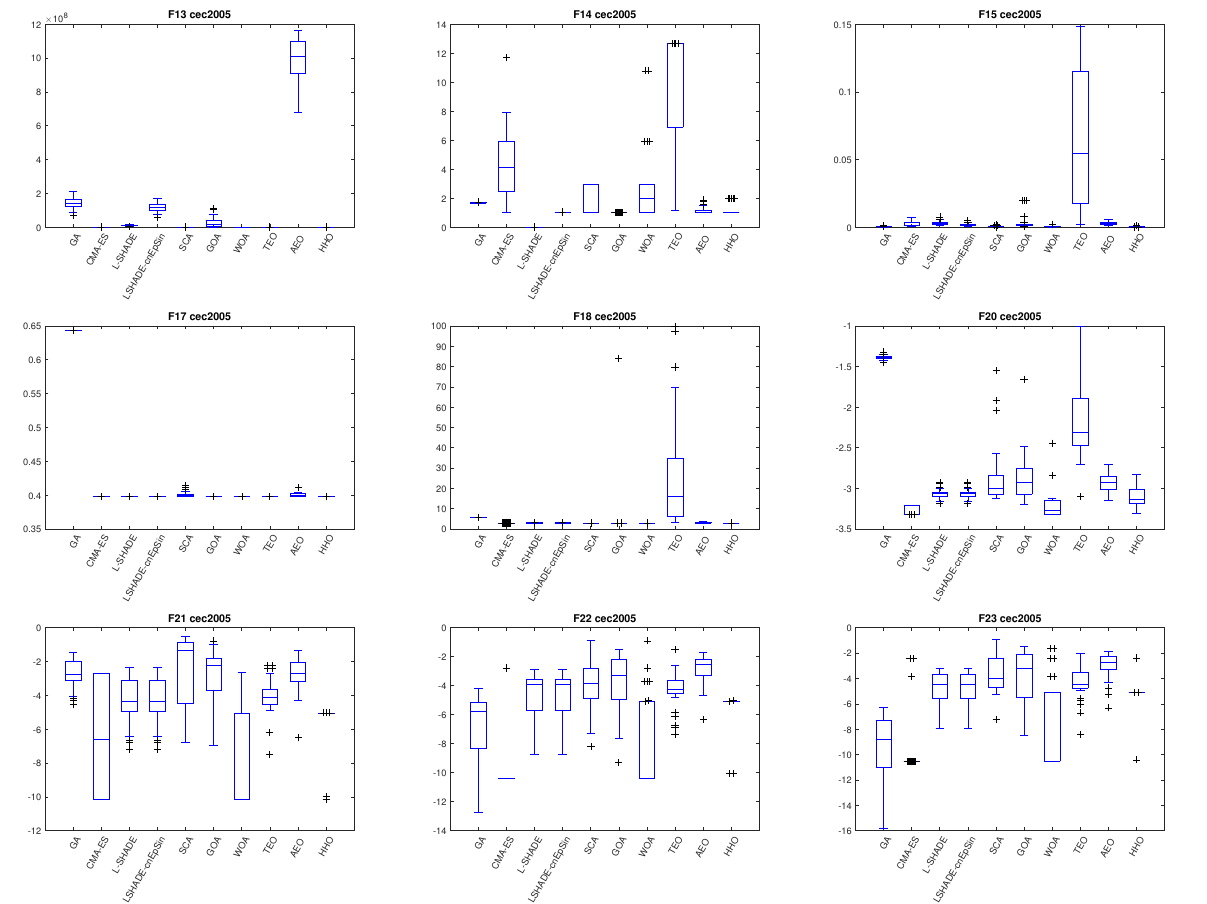
Figure 5. Boxplot of some functions from F13–F23 for all